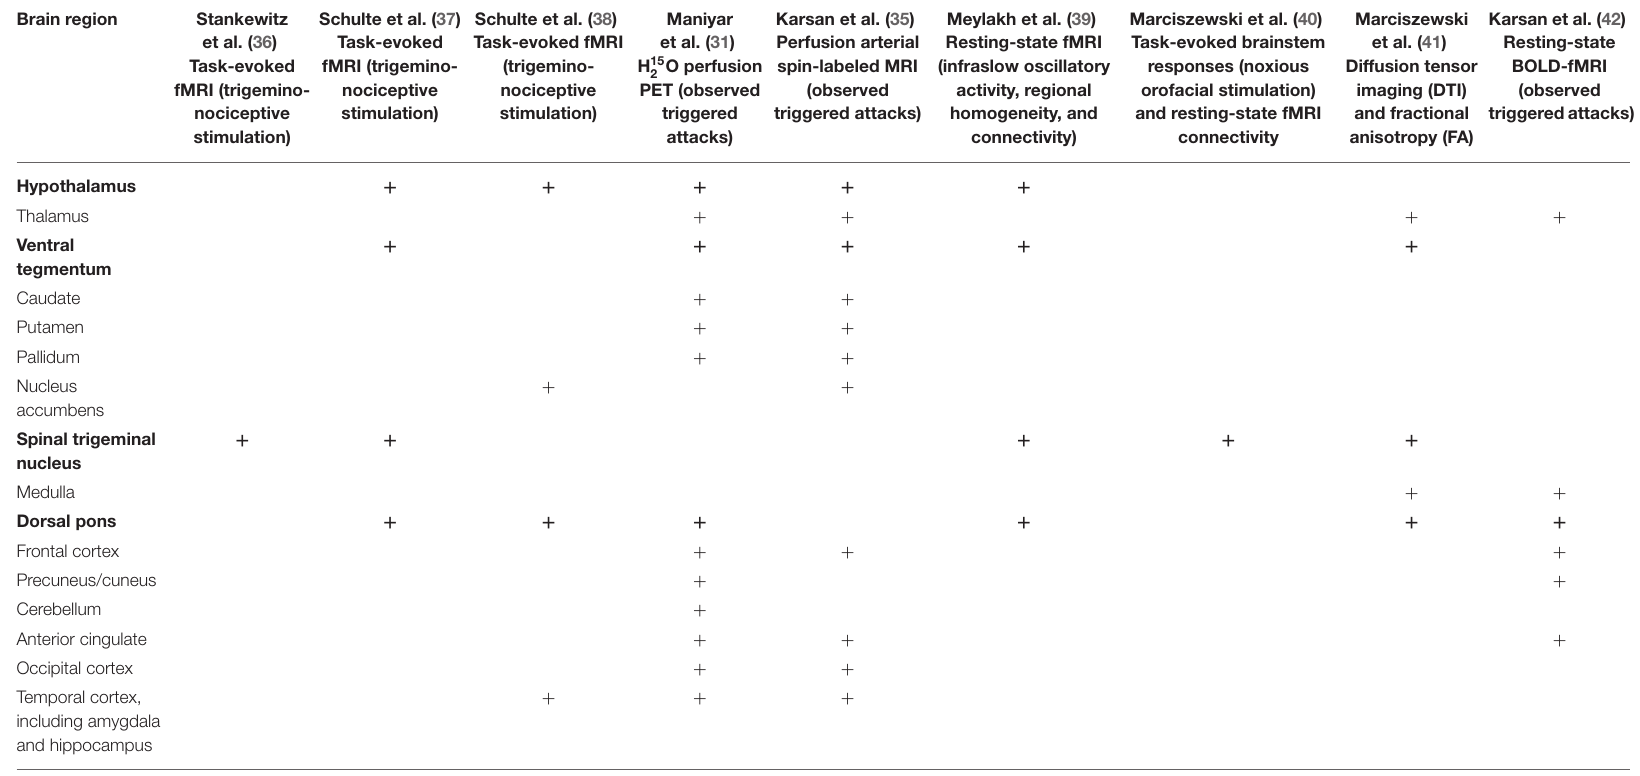
TABLE 1 | Comparison of the imaging findings of the different studies examining the premonitory or lead-up to headache phase of the migraine attack. Brain